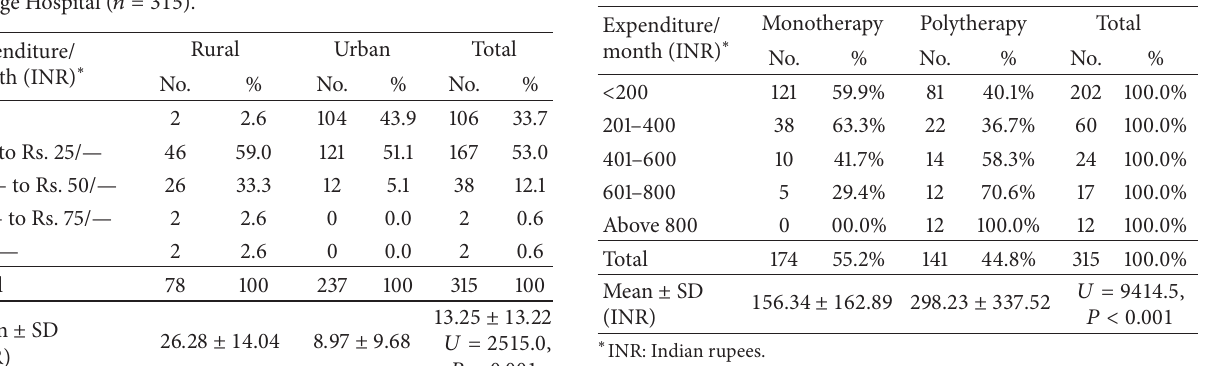
Table 6: Distribution of the average total expenditure for treatment of epilepsy according to mode of therapy ( 𝑛 = 315 ).